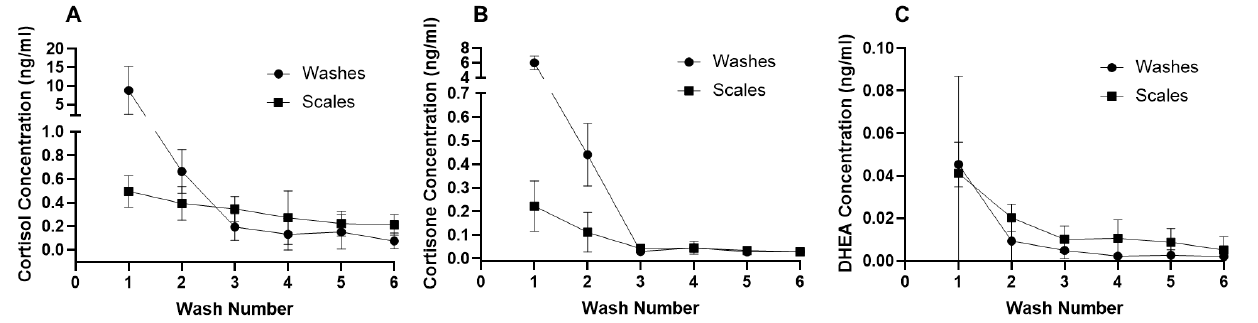
Figure 1. Validation of scale washing procedure: ( A ) cortisol, ( B ) cortisone and ( C ) DHEA concentrations in goldfish scale sample extracts washed 1-6 times are presented alongside their matching wash solution extracts. Error bars represent standard deviations; see text for further description of statistical analyses ( n = 3).